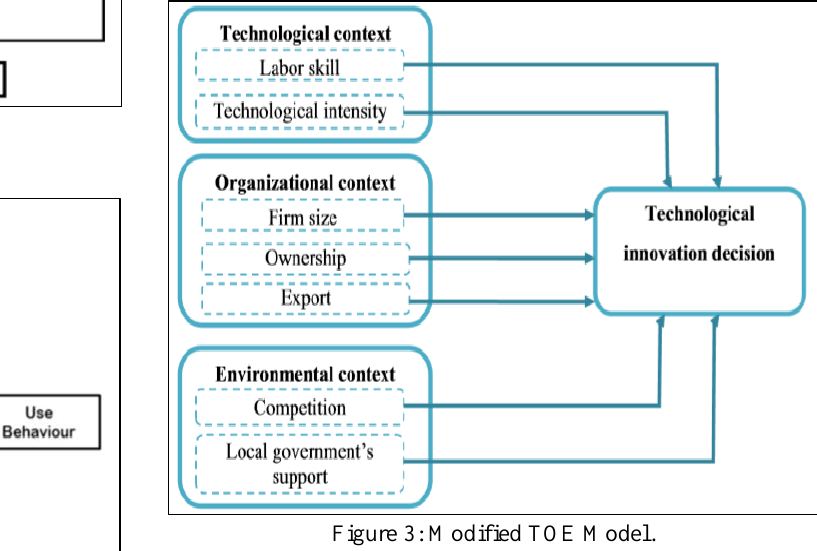
Figure 2: Modified UTAUT.